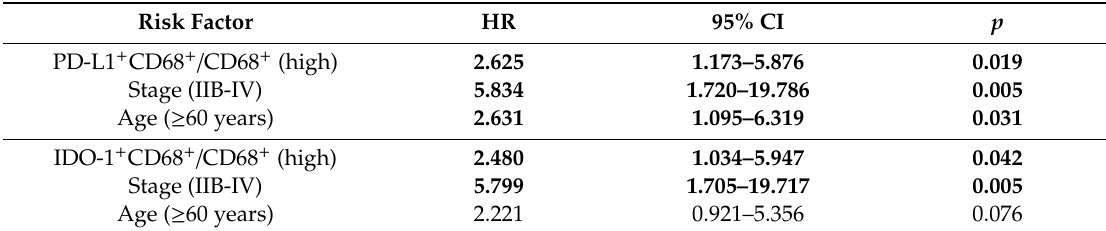
Cox regression analysis at multivariate level showing independent association